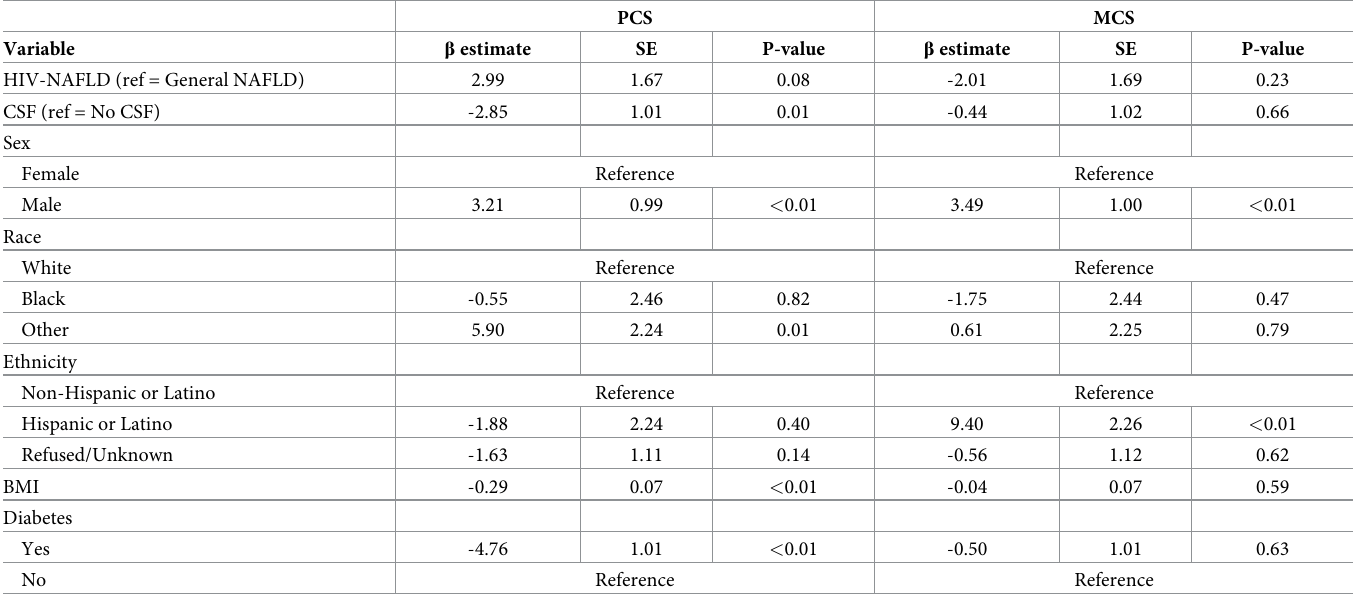
Table 5. Factors associated with physical and mental components of health-related quality of life in patients with NAFLD in multivariate